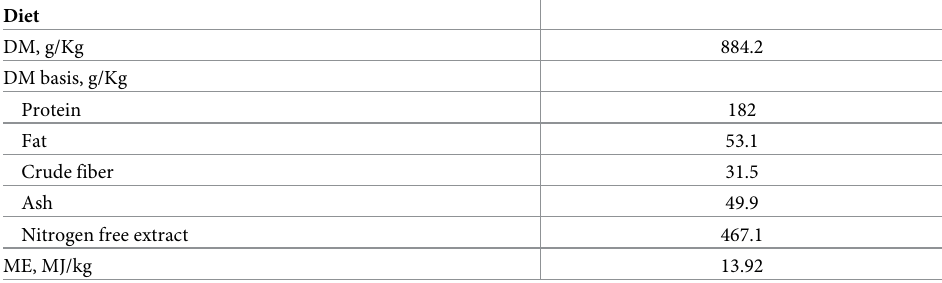
Table 1. Calculated composition of the diet used for